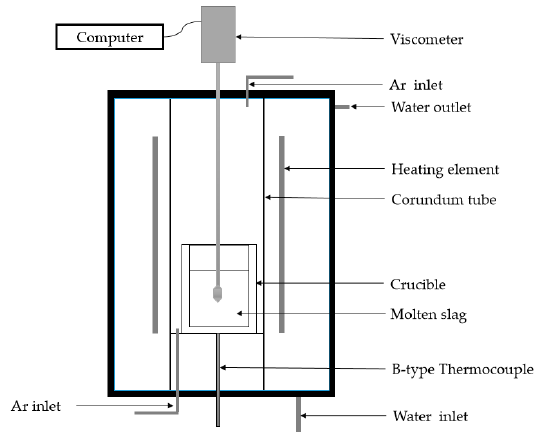
Figure 3. Diagram of the experimental apparatus used for viscosity measurements.